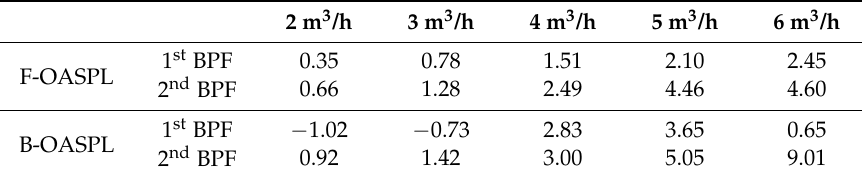
Table 2. Overall sound pressure level (OASPL) reduction of the first two orders (dB). F-OASPL: overall sound pressure level of forward radiation noise, B-OASPL: overall sound pressure level of backward radiation noise. 2 m 3 /h